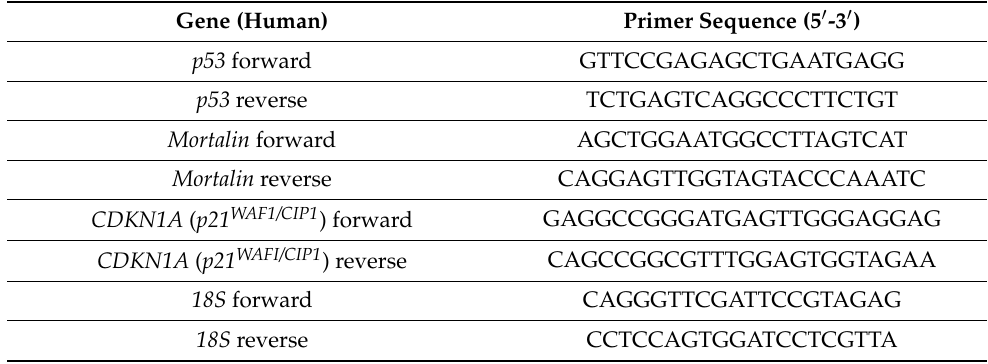
Table 2. Sequences of primers used for RT-PCR. Gene